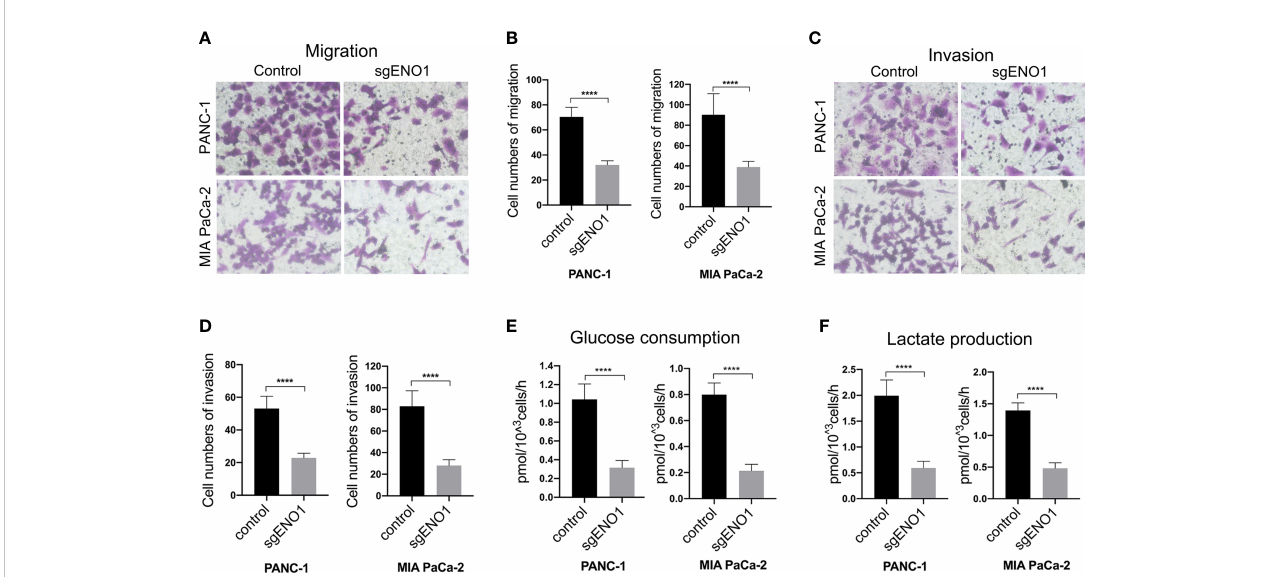
FIGURE 4 ENO1 knockout reduced cell migration, invasion, and glycolysis in PDAC cells. (A, B) The cell migration and (C, D) invasion decreased signi fi cantly after ENO1 knockout in PANC-1 and MIA PaCa-2 cells (transwell assay, ×200, n=3, error bars indicate S.D). (E) Glucose consumption and (F) lactate production signi fi cantly reduced after ENO1 knockout in PANC-1 and MIA PaCa-2 cells; ****P<0.0001.